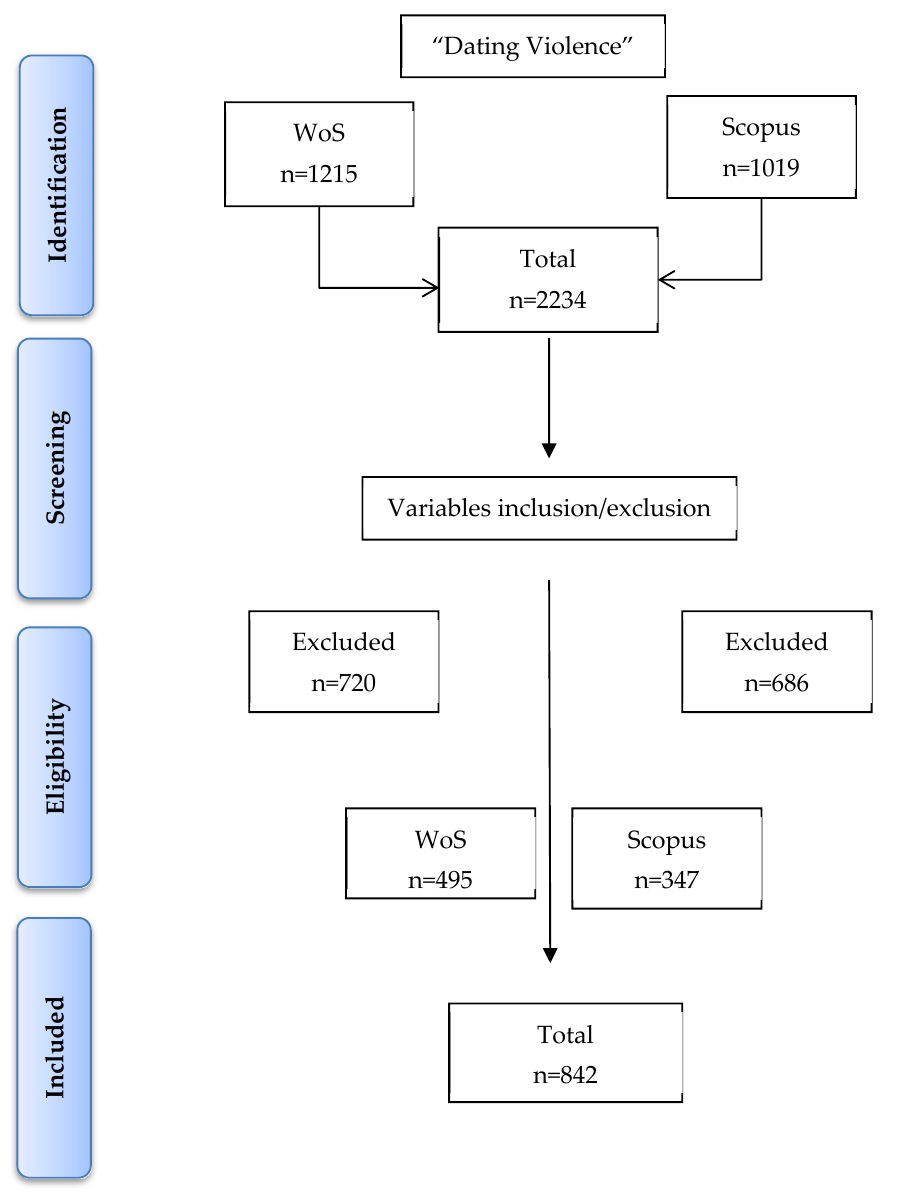
Figure 1. Flowchart of the review process.